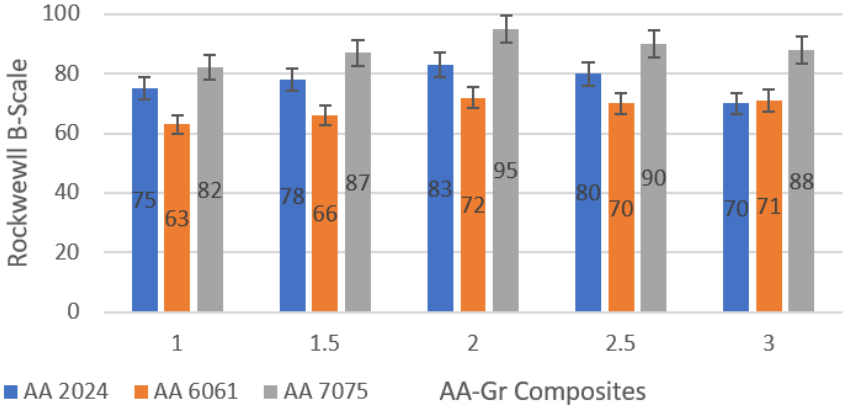
Figure 25. Hardness Evaluation of AA-Gr Composites.